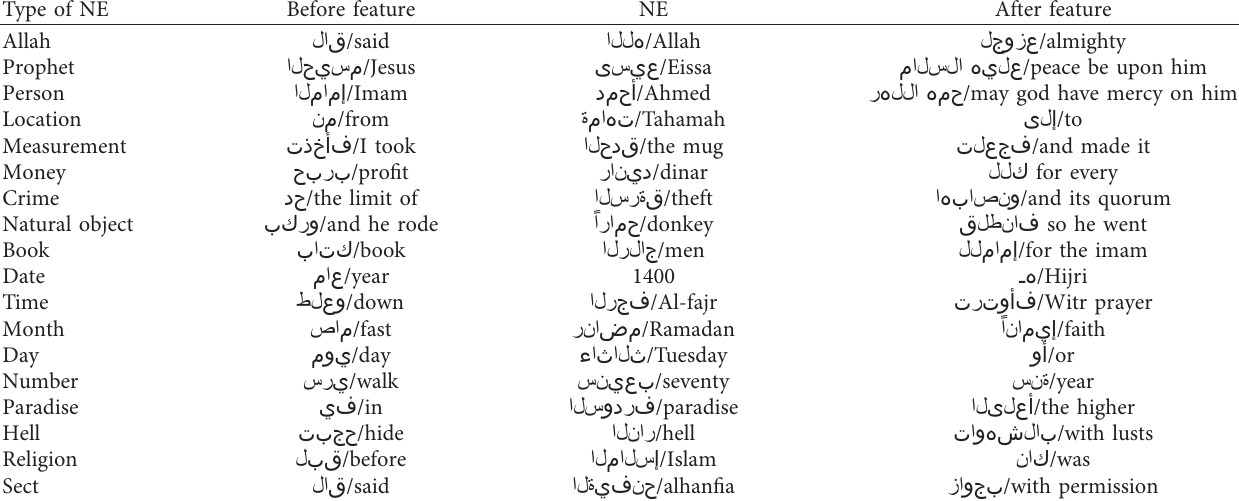
Table 3: Examples of